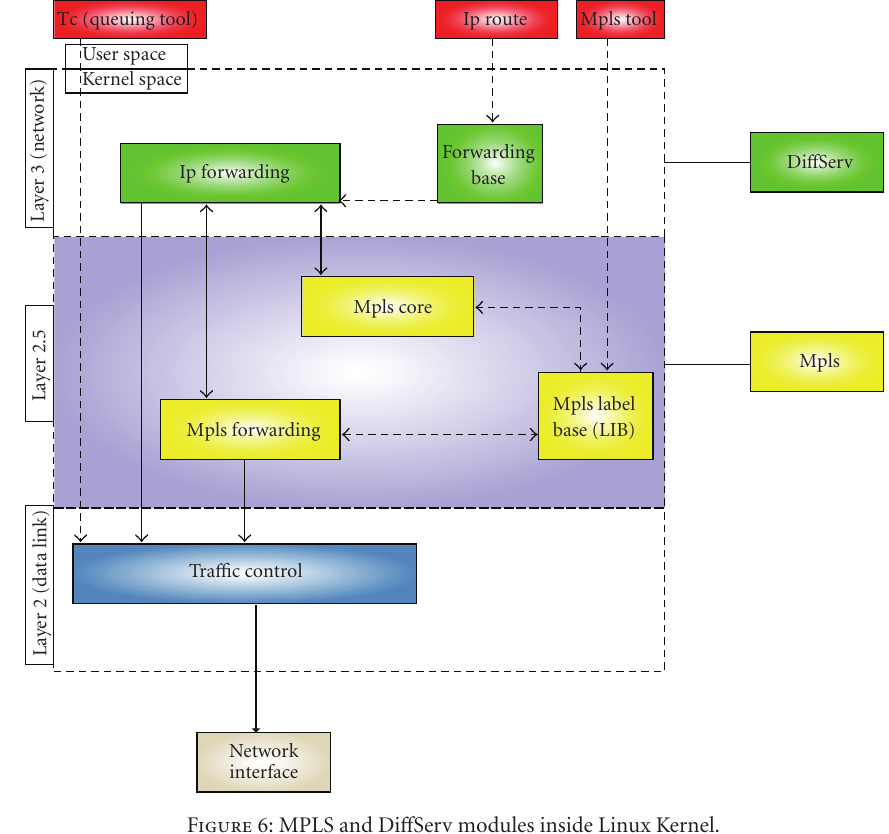
Figure 6: MPLS and Di ff Serv modules inside Linux Kernel.